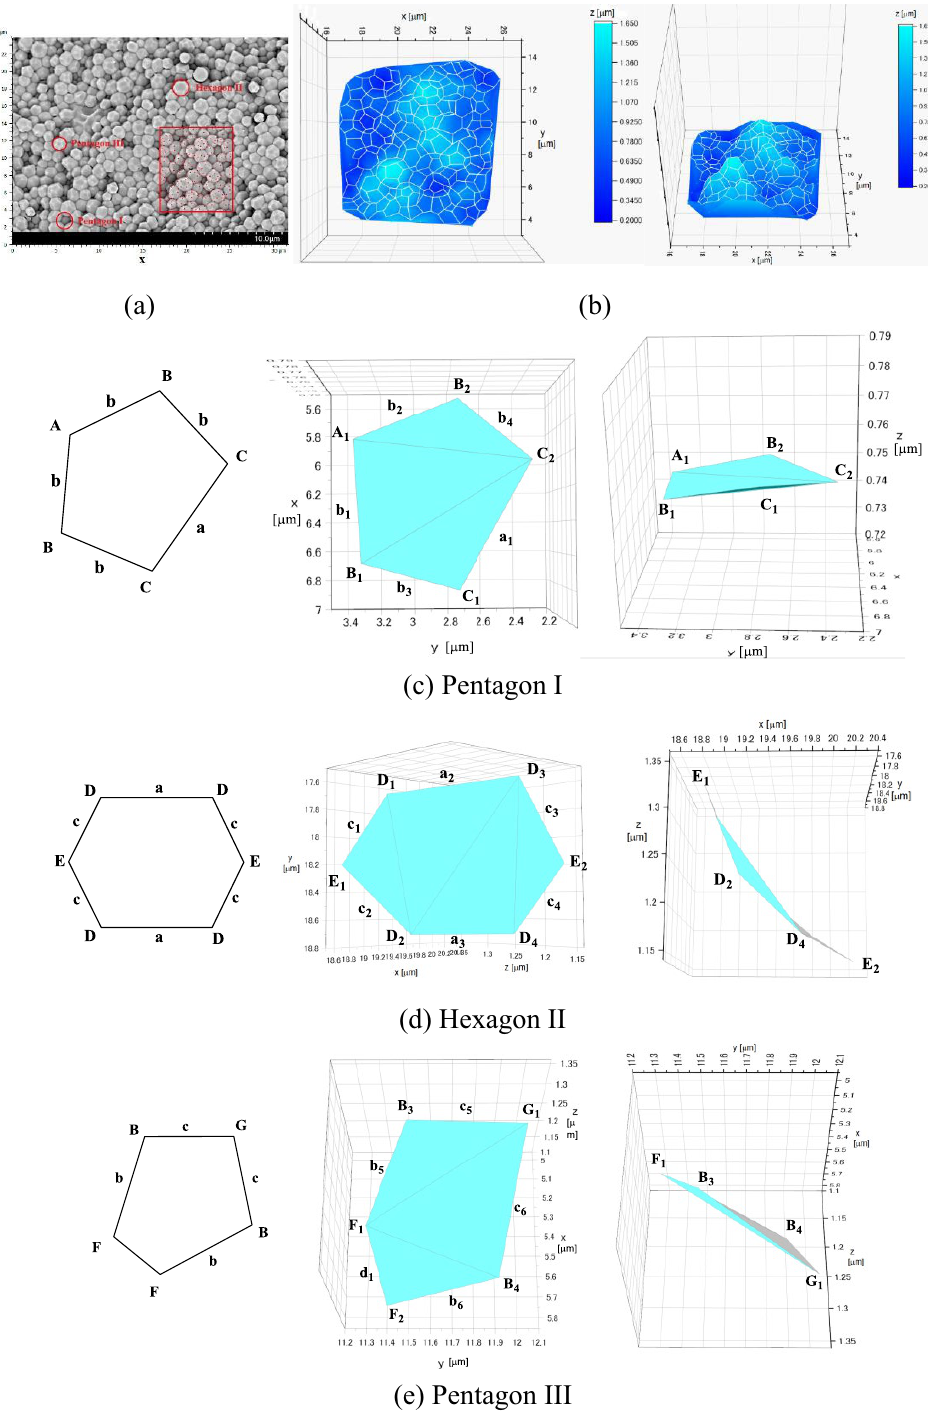
Figure 4. ( a ) A 3D SEM image, ( b ) bird’s eye views of the PEMP-HDI polymer of sample 3, 3D plots of ( c ) Pentagon I, ( d ) Hexagon II, and ( e ) Pentagon